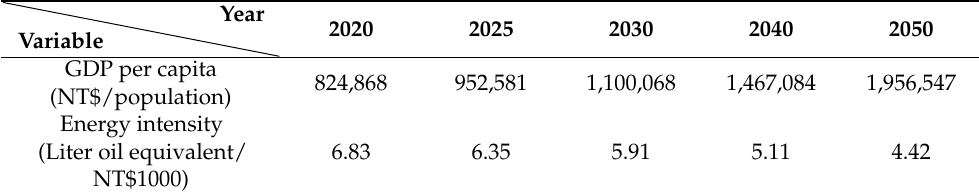
Table 5. Predicted value of selected variable.